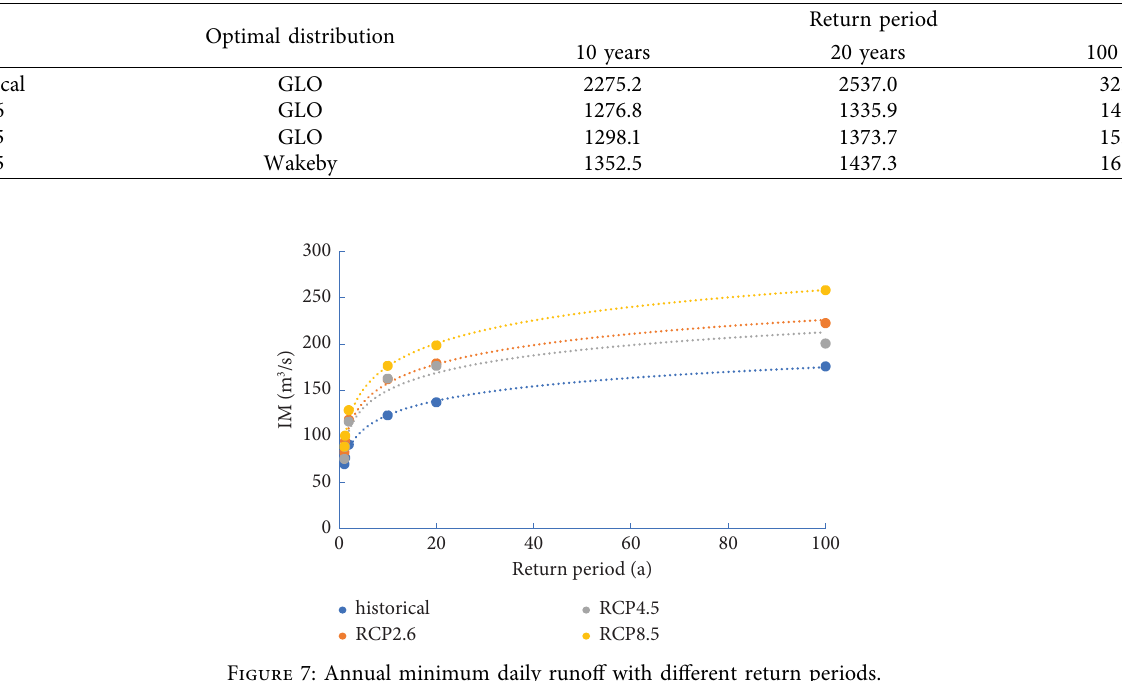
Table 11: Return period of annual maximum daily runof.